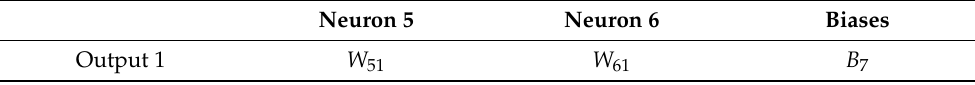
Table A3. Corresponding weights and biases between the output layer and hidden layer 2.